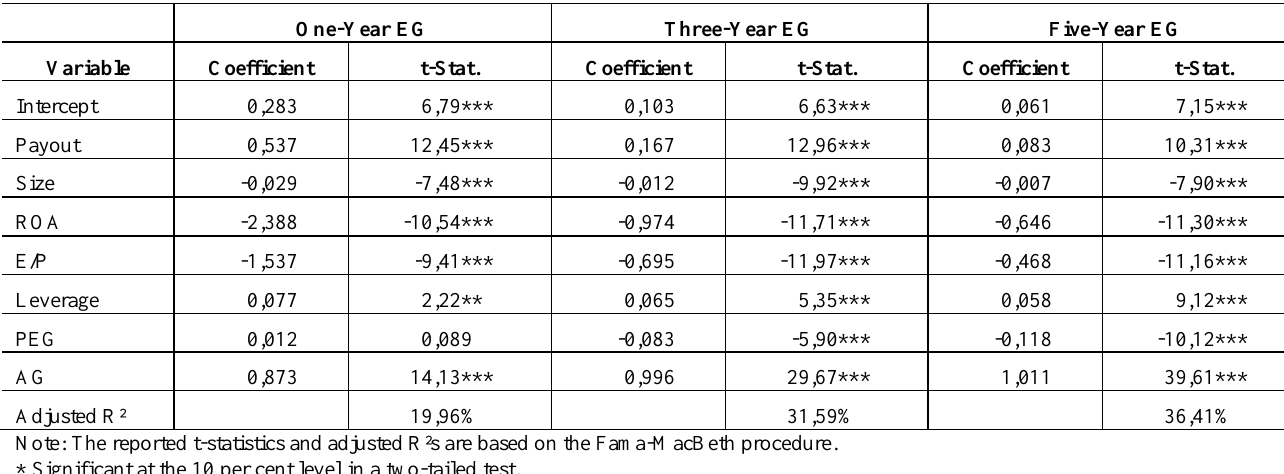
Table 6: Future earnings growth as a function of dividend payout (USA)